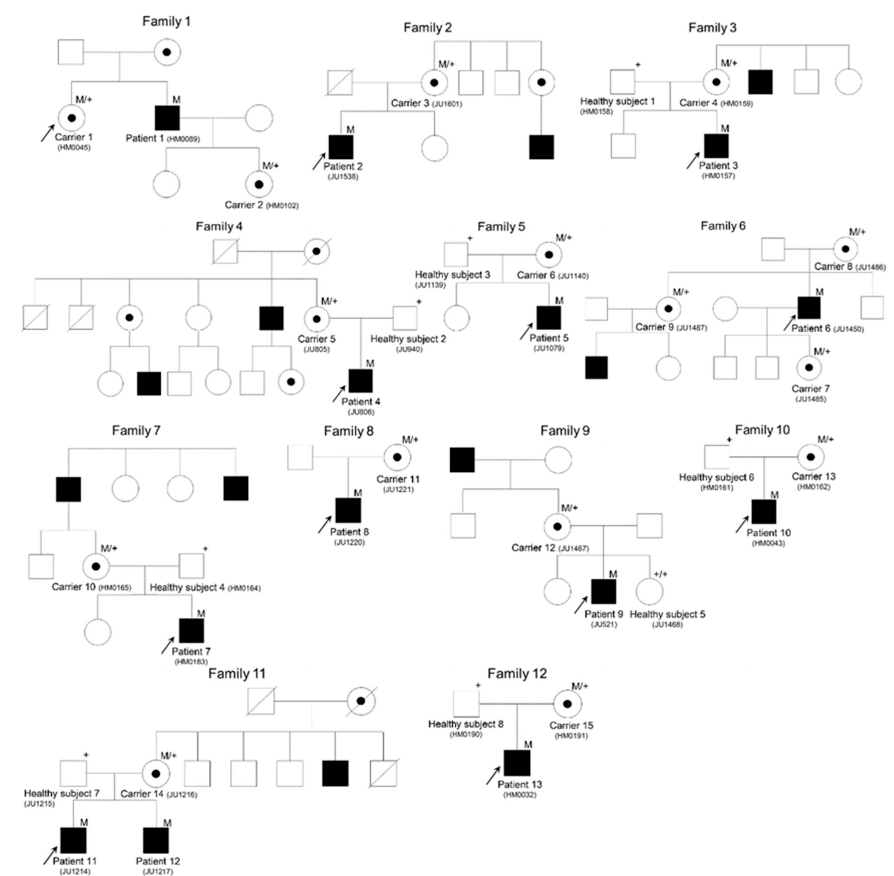
Figure 1. The pedigrees of the families in this study. Closed and open symbols represent affected and unaffected individuals, respectively. Dotted circles represent female carriers. Arrows indicate probands. The slash indicates a deceased person. M refers to the mutant allele and + to the normal allele.